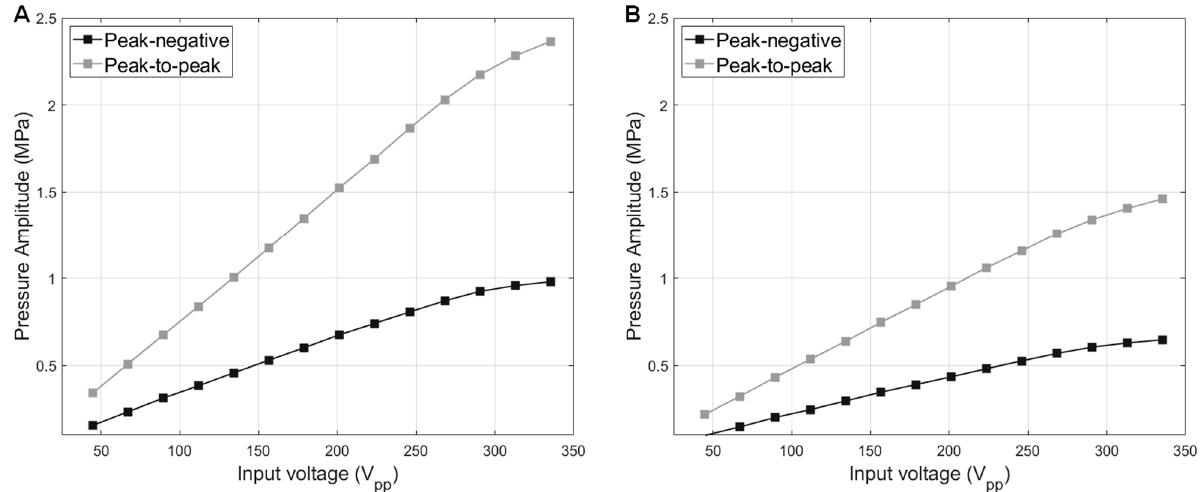
Figure 8. 10-cycle burst excitation pressure amplitude vs. input voltages. Both type A transducer ( A ) and type B transducer ( B ) were measured at the same axial distance (29 λ away from the transducer surface).